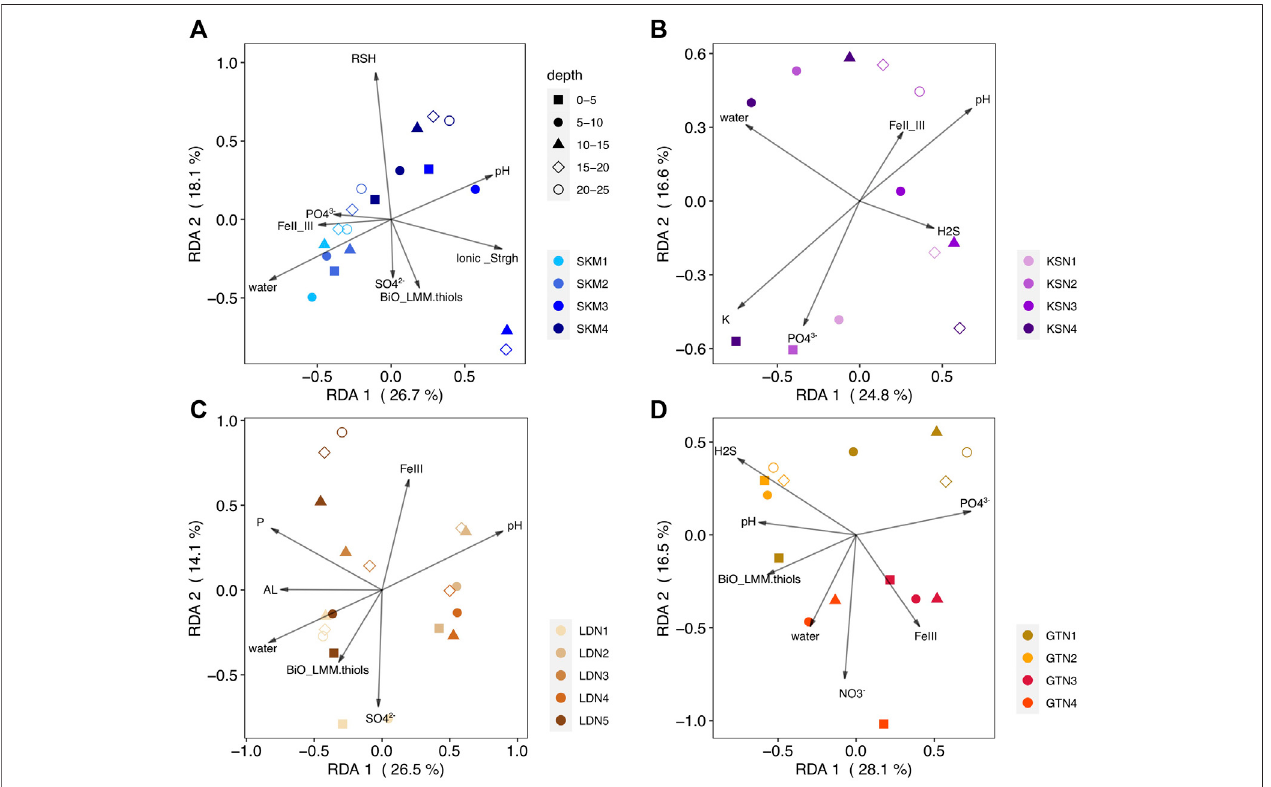
FIGURE 4 | RDA biplots (2 fi rst components) of the Hg II methylating microbial community (hgcA gene, OTU level) (response variable) constrained by physicochemical variables (predicting variable) and the studied sites [ (A) SKM, (B) KSN, (C) LDN, (D) GTN]. The color-coding in the legend indicates the sampling locations within a site. The shapes correspond to wetland core depth. The arrows and text summarize explanatory variables.